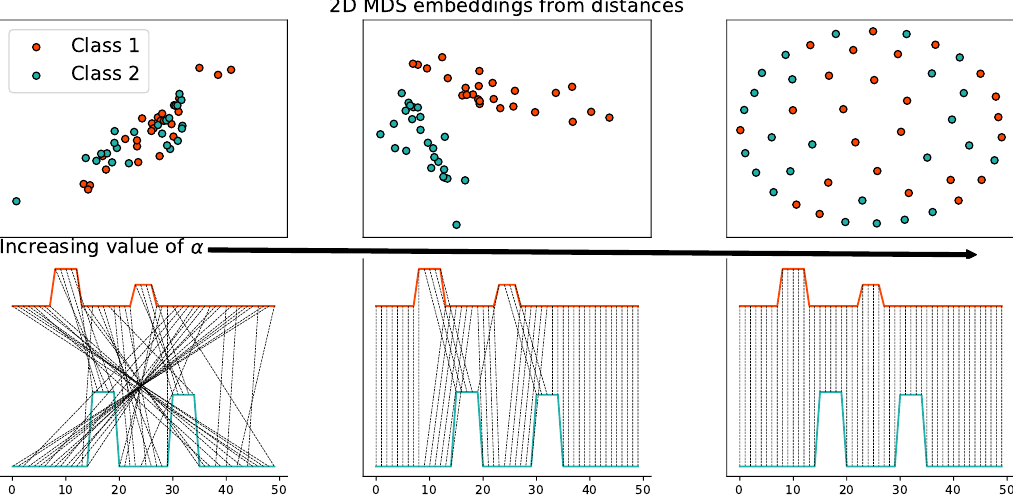
Figure 11. Couplings obtained when considering ( Top left ) the features only, where we have d Ω ( Top right ) the structure only, with d GW ,1 = 0 ( Bottom left , and right ) both the features and the structure, with d Ω . For readibility issues, only the couplings starting from non white pixels on FGW ,0.1,1,2 the left picture are depicted.